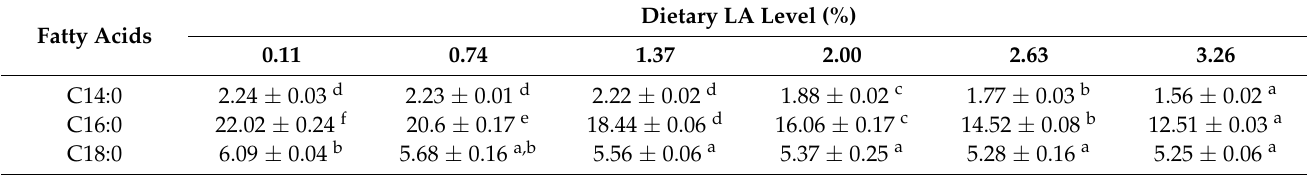
Table 5. Muscle fatty acid composition (% Total FA) of Oncorhynchus kisutch alevins fed with experimental diets with different dietary linoleic acid levels for 12 weeks (on dry matter basis) (means ± SE, n = 3). Dietary LA Level (%) Fatty Acids